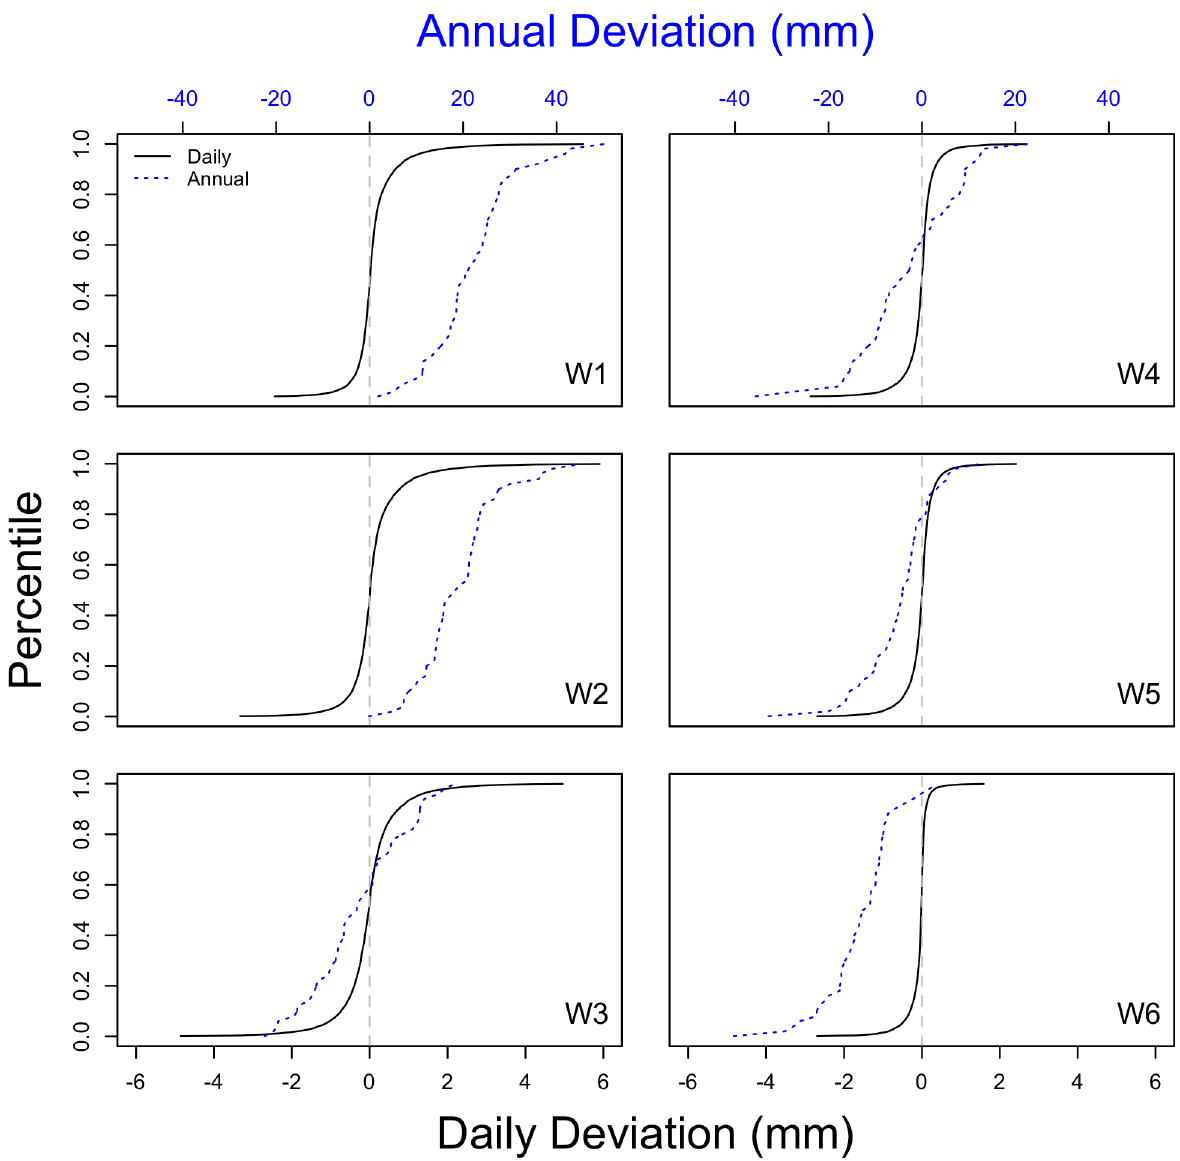
Fig 7. Cumulative frequency distributions of the catchment-scale precipitation deviations between estimates based on the reduced 6- gauge network (1, 2, 4, 6, 9, 11) for the south-facing catchments and estimates based on the full (12-gauge) network. The black line shows daily deviations and the blue line shows annual deviations. Only days with at least one gauge reporting precipitation were included in the daily deviation calculation. We used the precipitation record from 1964 to 2014 (the common time period when all gauges were in operation). The scale for annual deviations is at the top and for daily deviations is at the bottom. Note that the direction of skewed daily deviations, most visible in the heavy tail, corresponds with the direction of bias in the annual